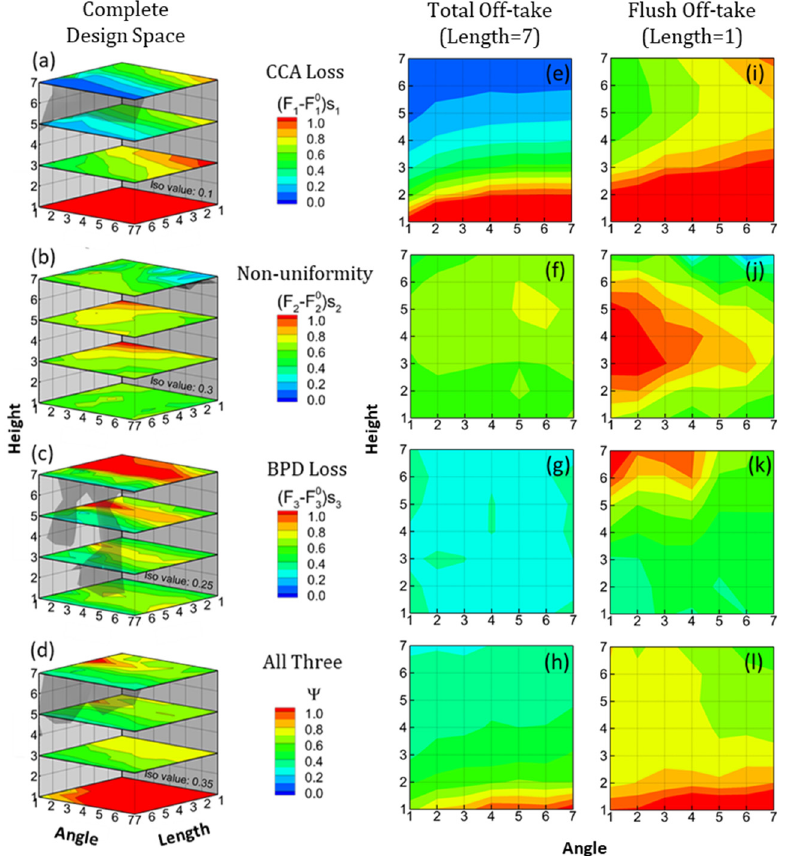
Figure 15. Model 1 (DoE 1) system responses. Full design variable space ( a – d ), total offtakes ( e – h ), and flush offtakes ( i – l ).